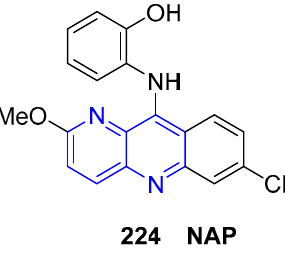
Figure 24. Fused 1,5-naphthyridine as colorimetric sensor for detection of Cu 2+ ions.